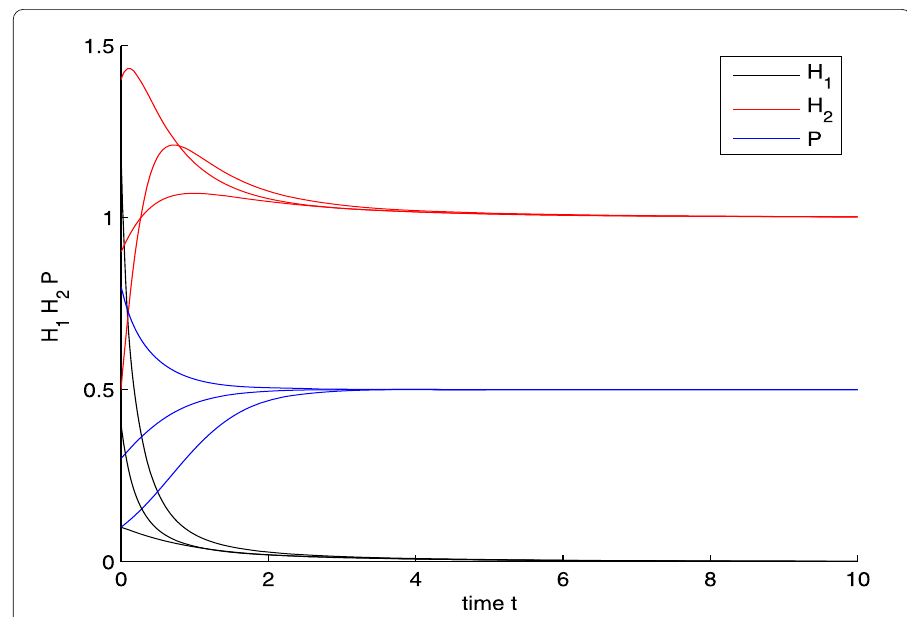
Figure 2 Dynamical behavior of system (5.2) with initial values (0.4,1.4,0.8) T , (0.1,0.9,0.3) T and (1.2,0.5,0.1)